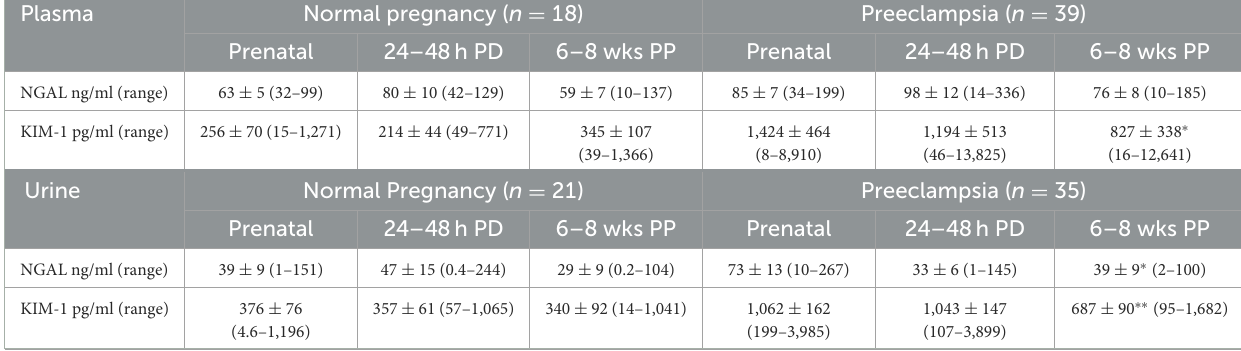
TABLE 4 Prenatal and postpartum plasma and urine levels of NGAL and KIM-1 in normal and preeclamptic pregnant women.